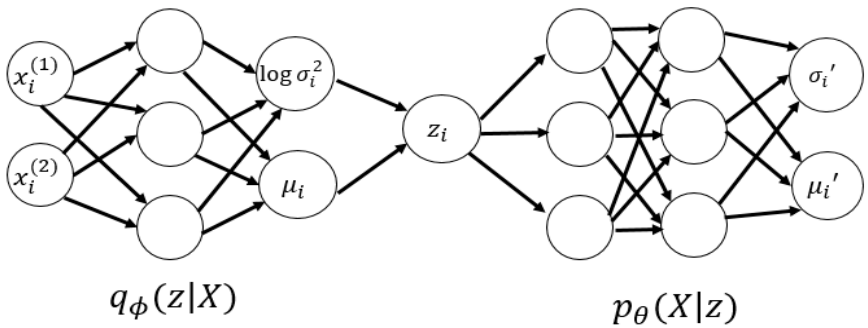
Figure 5. Graphical representation and steps of the VAE model in this study.